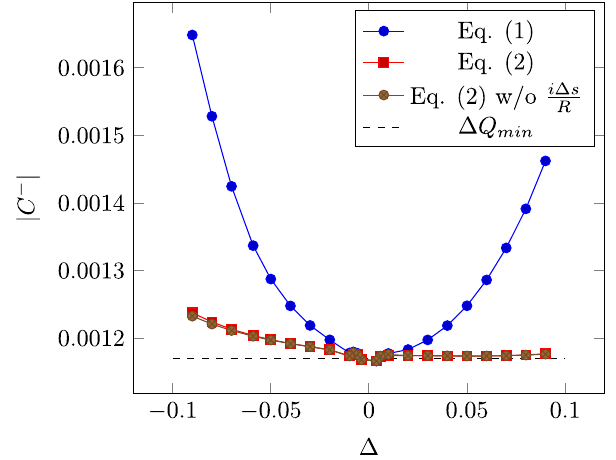
FIG. 1. A comparison of Eqs. (1) and (2) to calculate the Δ Q from f 1001 . Q y was kept constant at 59.31 while Q x was varied between 64.22 and 64.40. Injection optics for the LHC was used in the